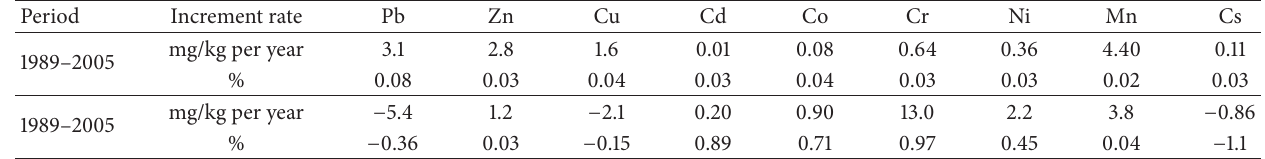
Table 3: Mean surplus/decrease rate of HM contents in topsoils of the Eastern district of Moscow.